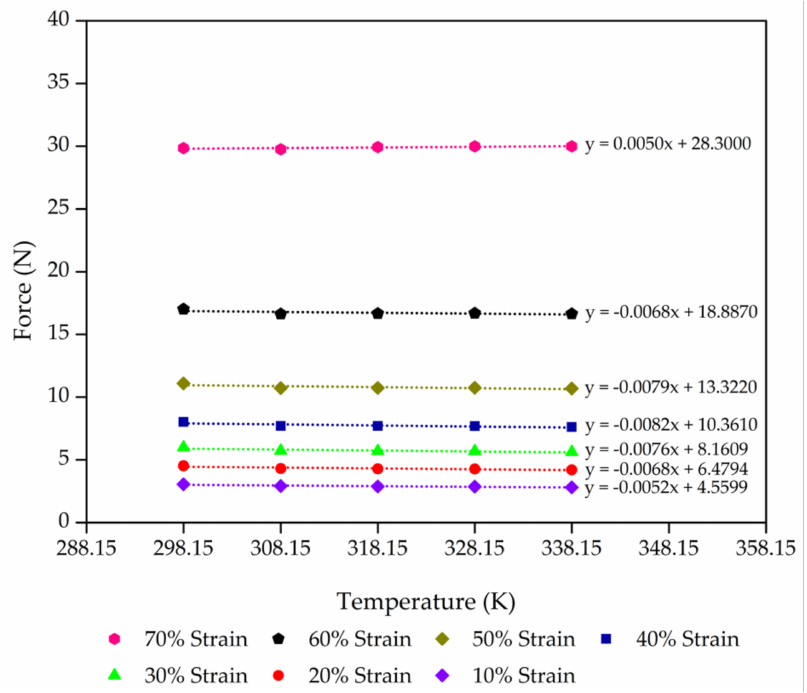
Figure 5. Compression force as a function of the temperature of the control - 15% Po sample from 10% to 70% compression strain with a minimum linear regression (R 2 ) = 0.9 at each strain. The scatter on the results is on the order of the size of the data